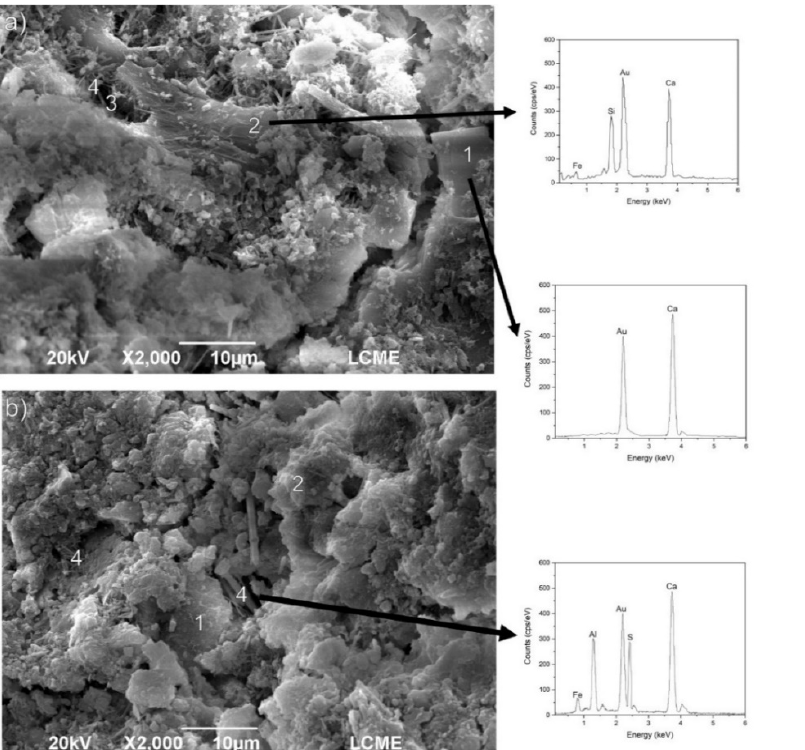
Figure 12. a) SEM images of 0NS and b) 0.4NS at 28 days and correspondent EDS. Legend: 1 = portlandite; 2 = C–S–H; 3 = pore; 4 =